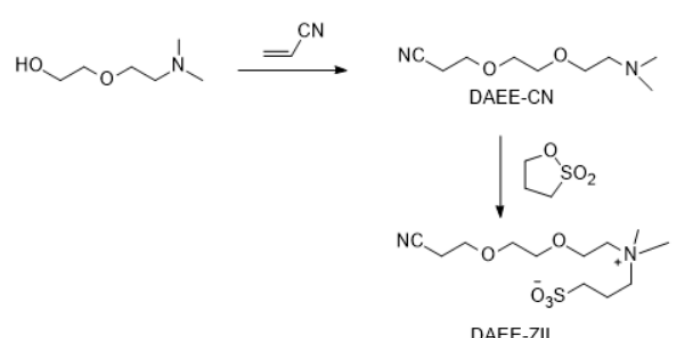
Figure 8. Synthesis of DAEE-ZIL.